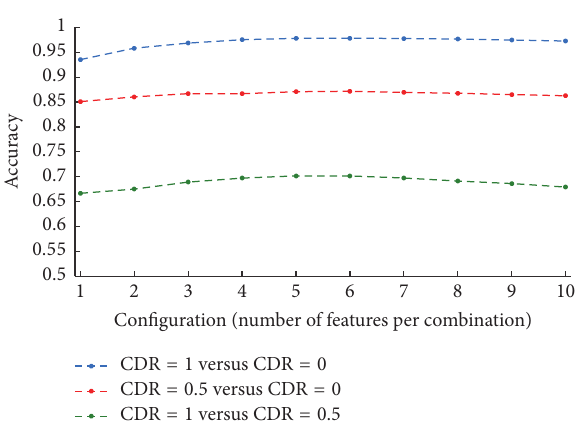
CDR = 1 versus CDR = 0, CDR = 0.5 versus CDR = 0, and CDR = 1 versus CDR = 0.5 is reported.